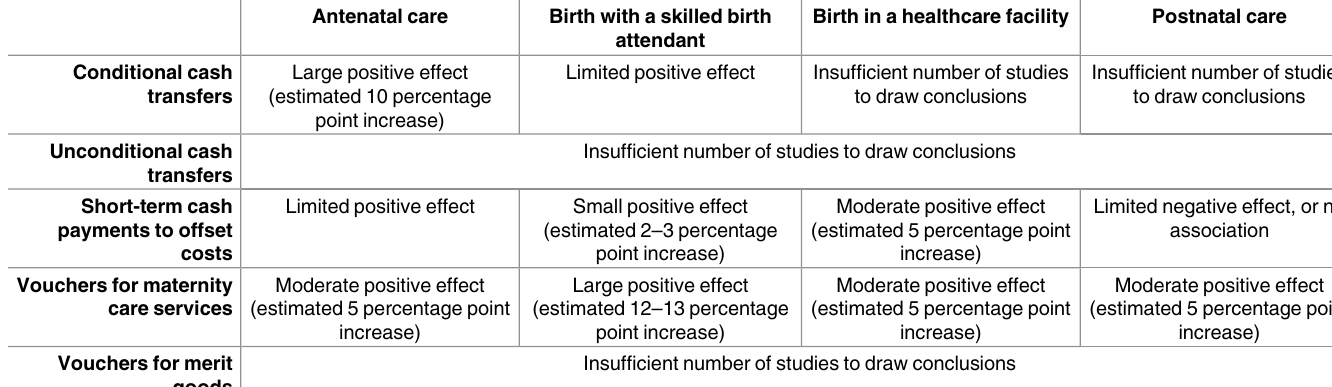
Table 8. Summaryof results from albatross plots for effectsof demand-side financing on use of maternity care